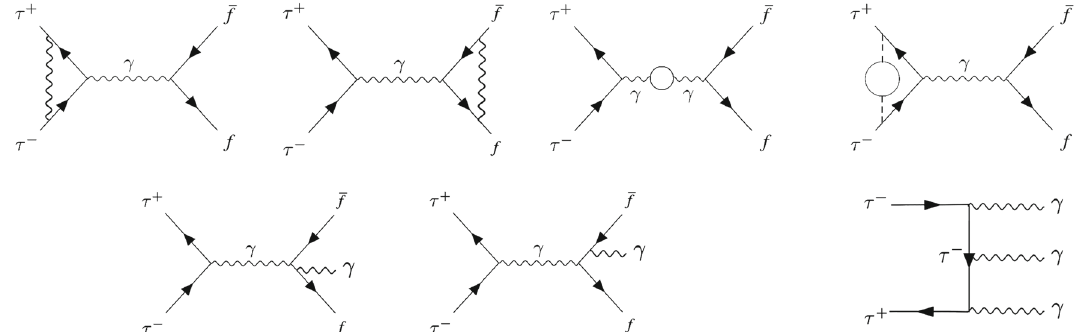
Fig. 6 Higher-order corrections to ortho-ditauonium 1 3 S 1 decays. The five leftmost diagrams show NLO virtual (top) and real (bottom) bremsstrahlung corrections to the 1 3 S 1 difermion decays. Top right: Wavefunction at the origin corrections to the 1 3 S 1 difermion decays. Bottom right: 3-photon